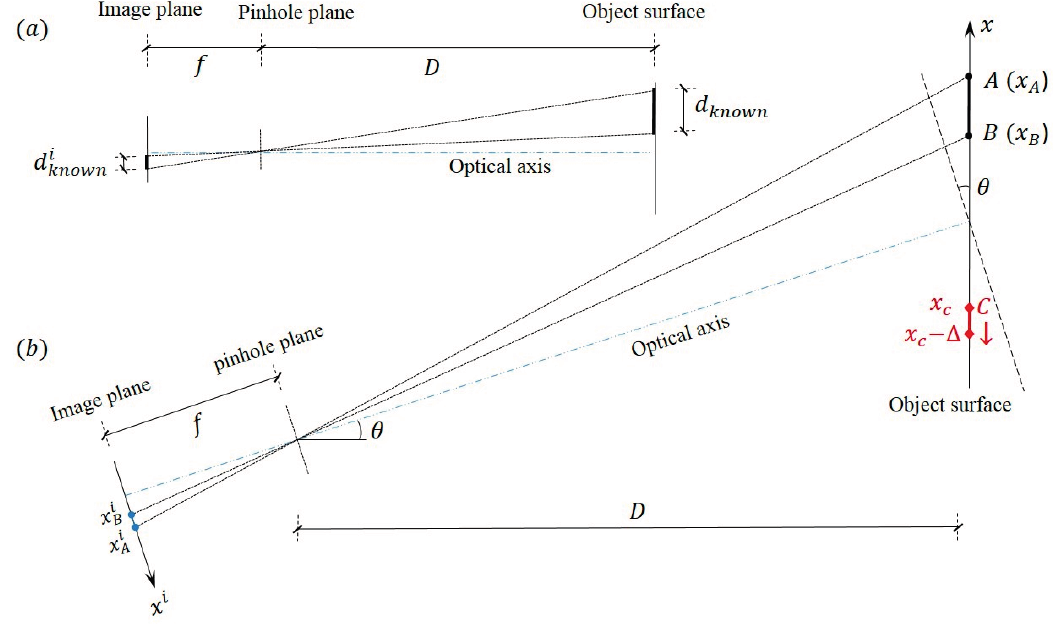
Figure 2. Scaling factor determination: ( a ) optical axis perpendicular to object surface; ( b ) optical axis non-perpendicular to object